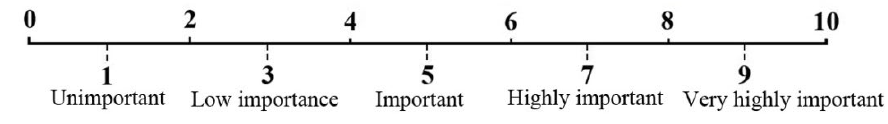
Fig. 3: Likert range for determination of the important level of criteria ( Mafi-Gholami et al ., 2015b )